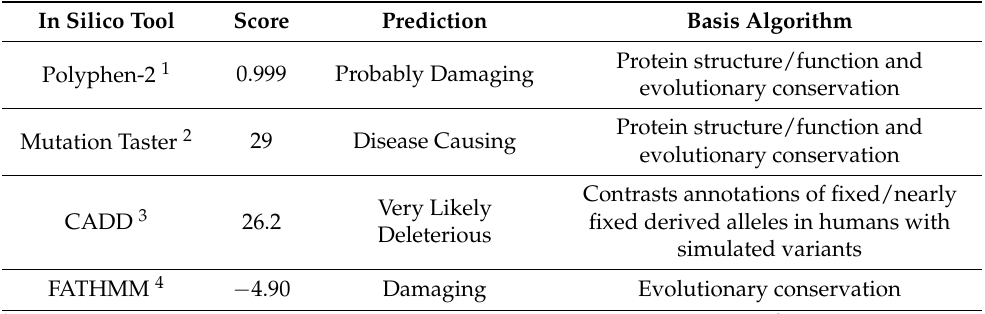
Table 3. In silico tools used to analyze the pathogenicity score of the LMNA p.R545H variant. In Silico Tool Score Prediction Basis Algorithm